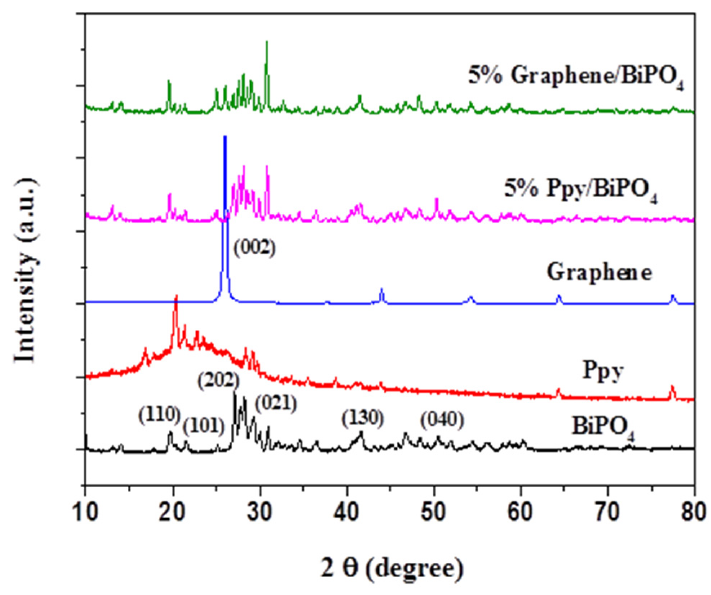
Figure 2. XRD pattern of BiPO 4 , PPy, graphene, 5 wt.% PPy/BiPO 4 , and 5 wt.% graphene/BiPO 4 composites.